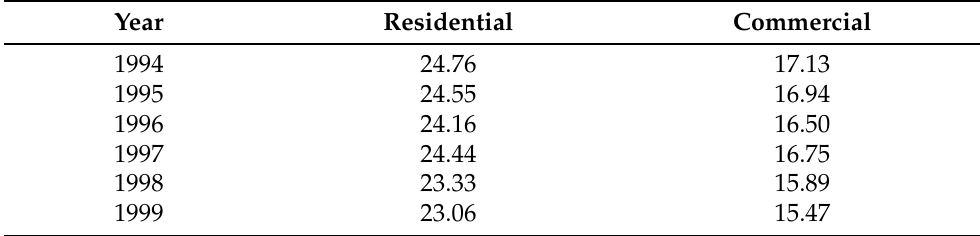
Table A1. Cost of electricity between 1994 and 2016 (the last year that data are available) [JPY/kWh]